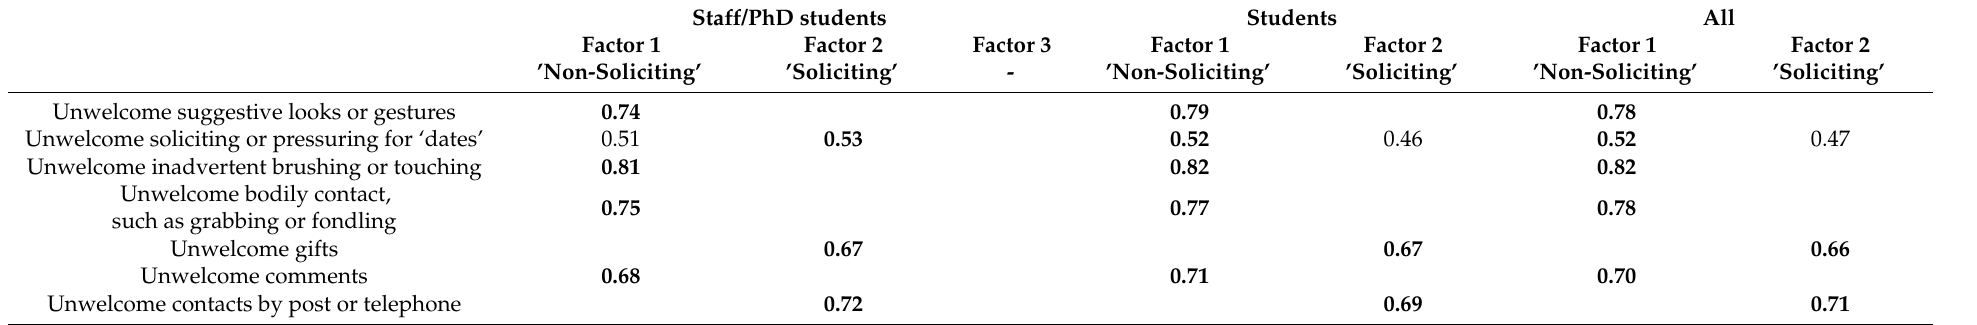
Table 4. Exploratory factor analysis performed with Varimax rotation on the 10 SH items in the Tellus survey. Staff/PhD